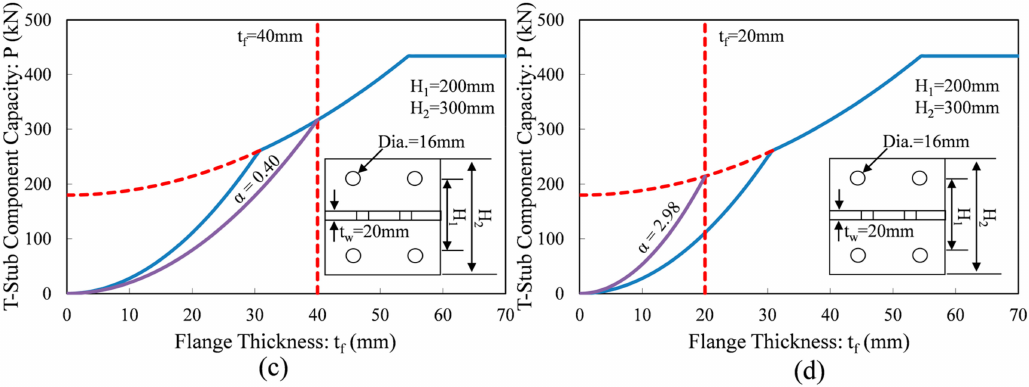
Figure 7. Design results based on prying action mechanism: ( a ) Case-3; ( b ) Case-7; ( c ) Case-11; ( d ) Case-15.